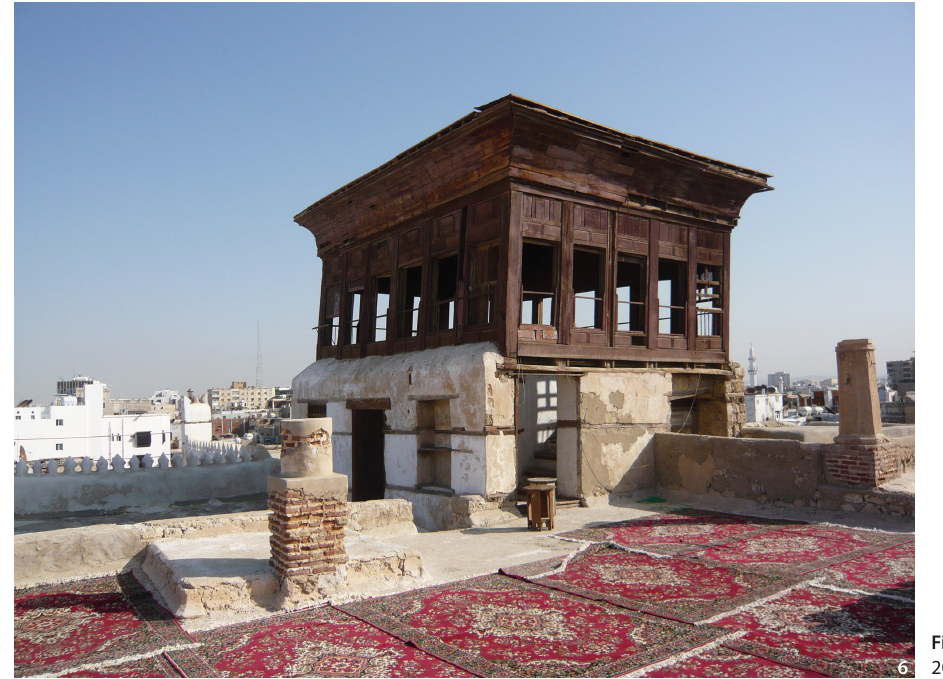
Figure 6 Khushk of Naseef House, 2009 (Source: the author).